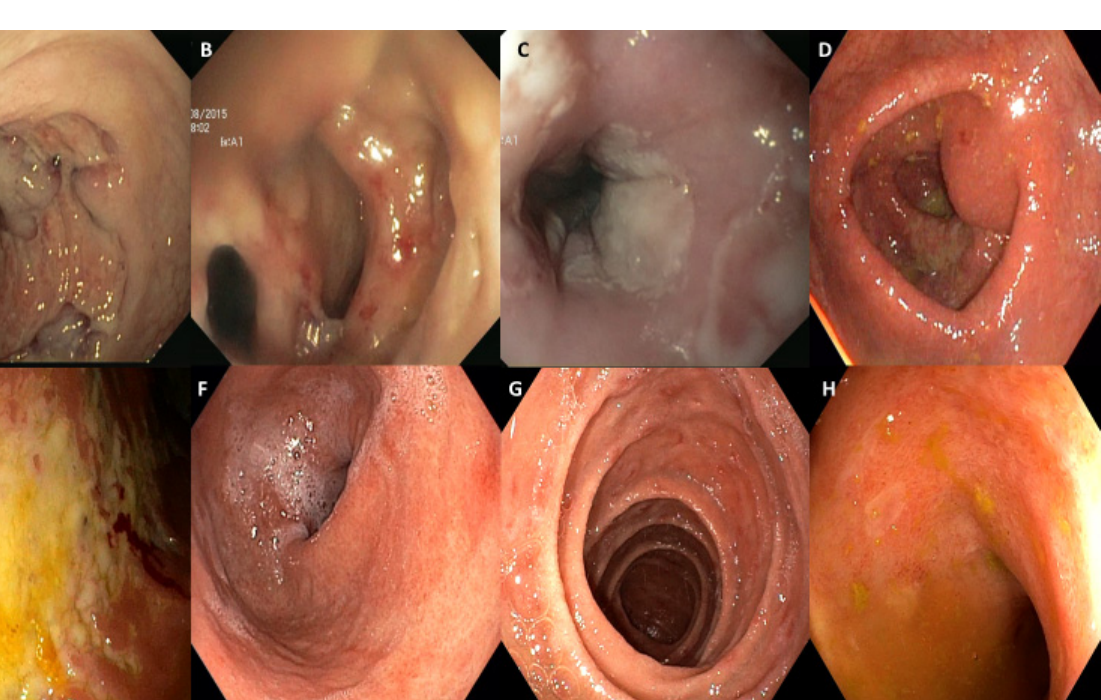
Figure 2. Apoptotic pattern colitis: ( A ) right colon, 9×, showing glandular atrophy and distortion; ( B ) apoptotic bodies in the glandular element, 25× (hematoxylin and eosin).